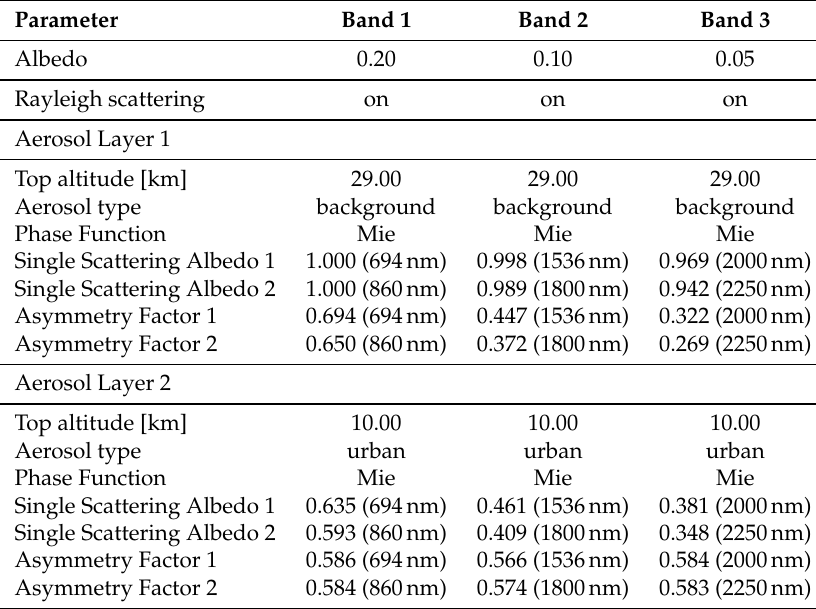
Table A10. Scattering parameters of scenario Rayleigh+Aerosol urban